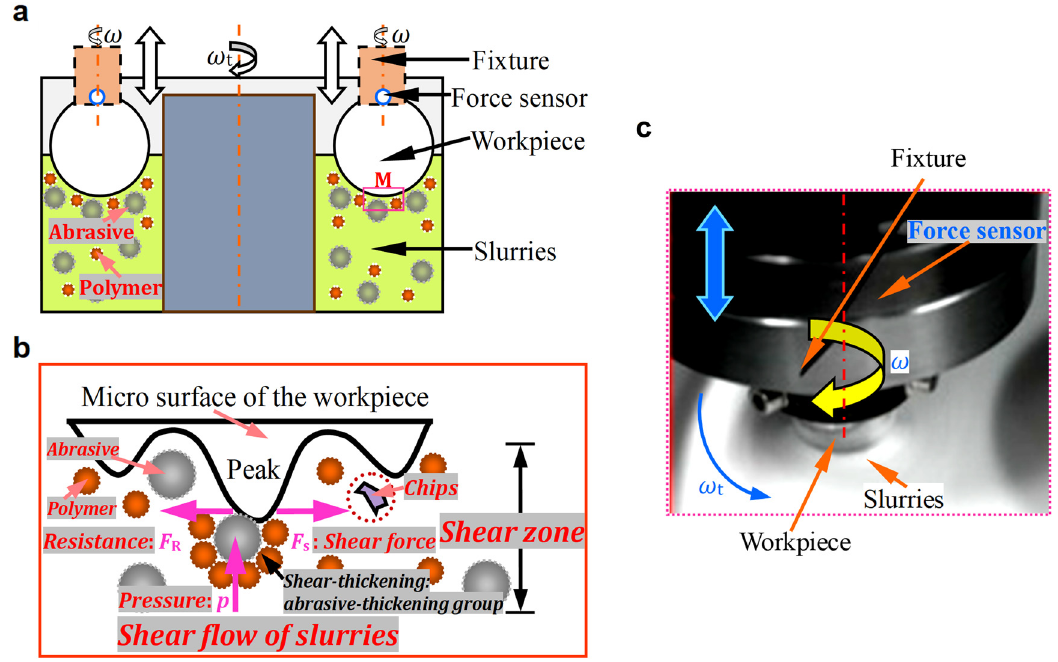
Figure 1: Schematic of the ultraprecision machining process: ( a ) polishing system; ( b ) material removal principle; ( c ) self - developed experimental device and magni fi cation region M of ( a )